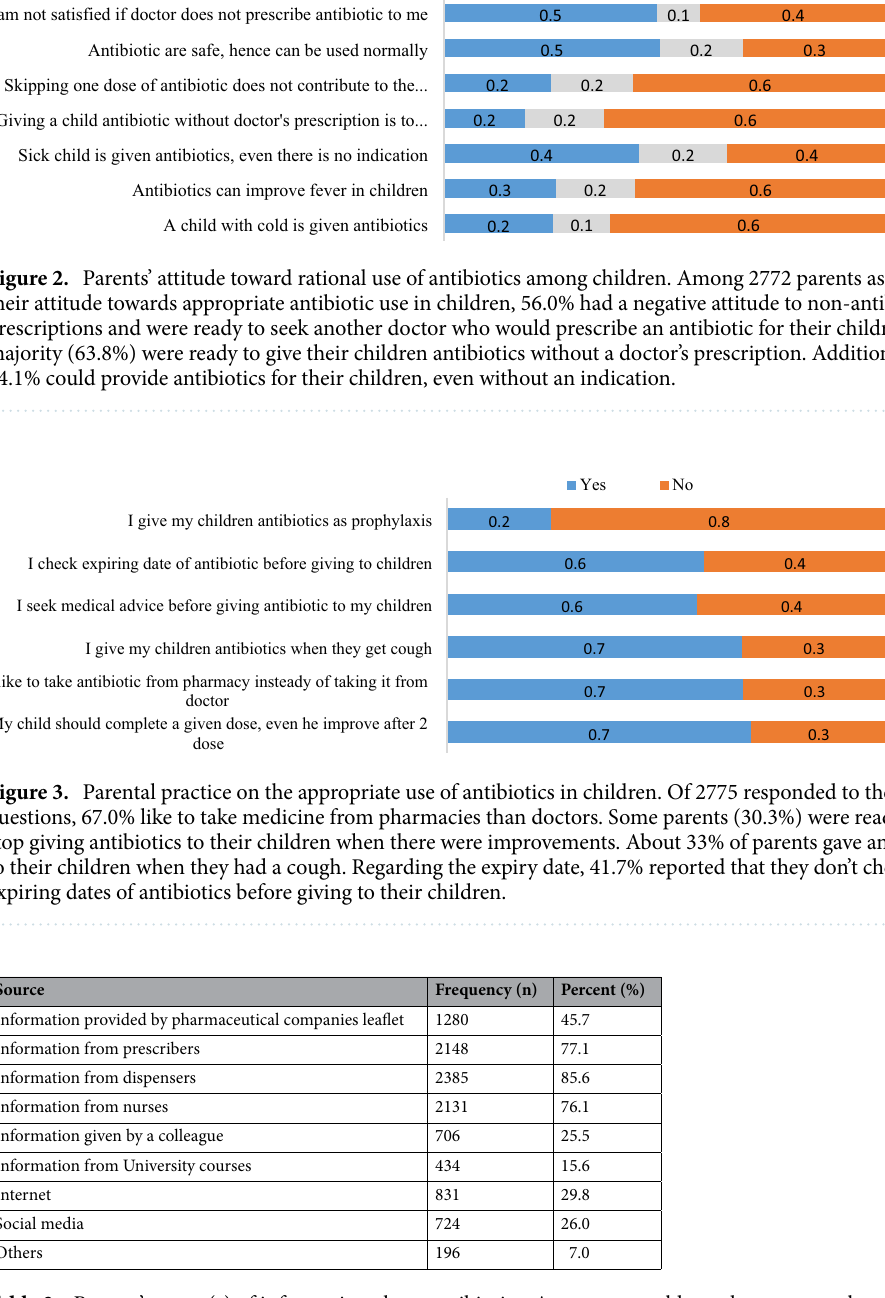
Table 2. Parents’ source(s) of information about antibiotics. A parent was able to choose more than one source. Hence, the total percentage is more than